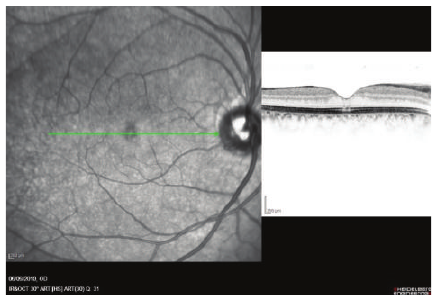
Figure 1: Spectral domain optical coherence tomography (Spec- tralis; Heidelberg Engineering, Heidelberg/Germany) of the right eye. Subfoveal inner segment band loss and cone outer segment tips elevation.